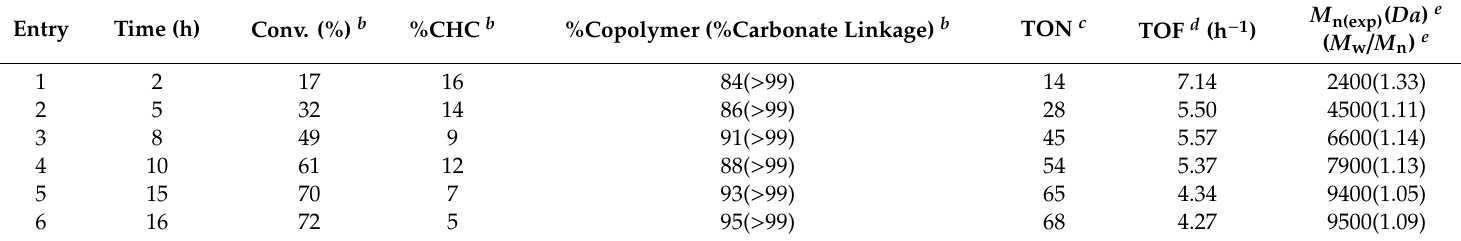
Table 5. E ff ect of reaction time on the synthesis of poly(cyclohexene carbonate) catalysed by complex 4 a